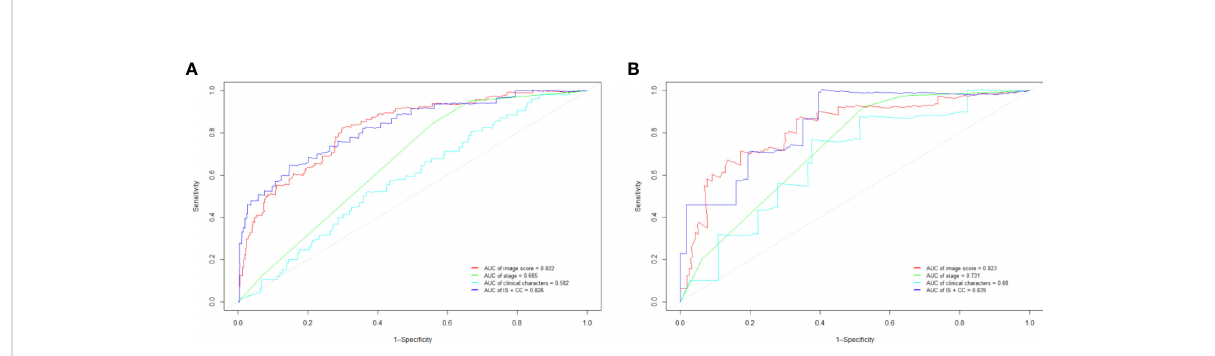
FIGURE 3 The receiver operating characteristic curve (ROC) in training cohort (A) and validation cohort (B) . IS, image score; CC, clinical characters.